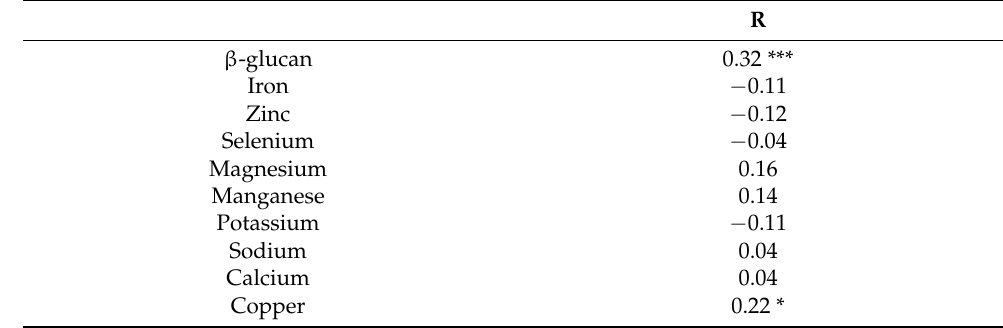
Table 4. Pearson’s correlations between bulk and single plant derived seeds of Hordeum spontaneum accessions for β -glucan and